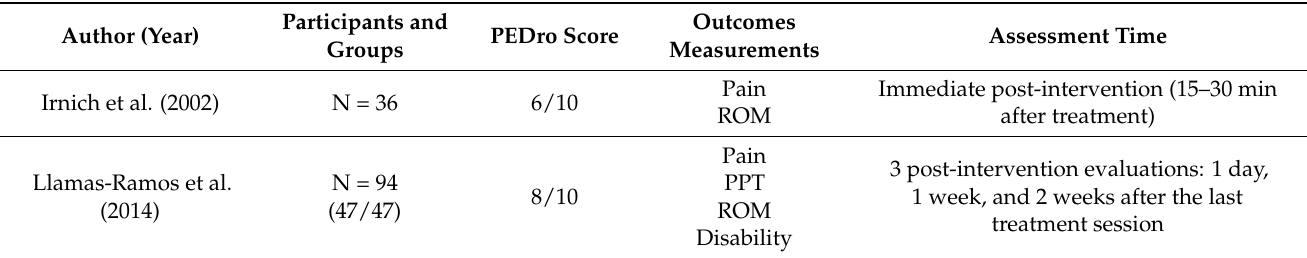
Table 1. Characteristics of the clinical trials included in the systematic review.